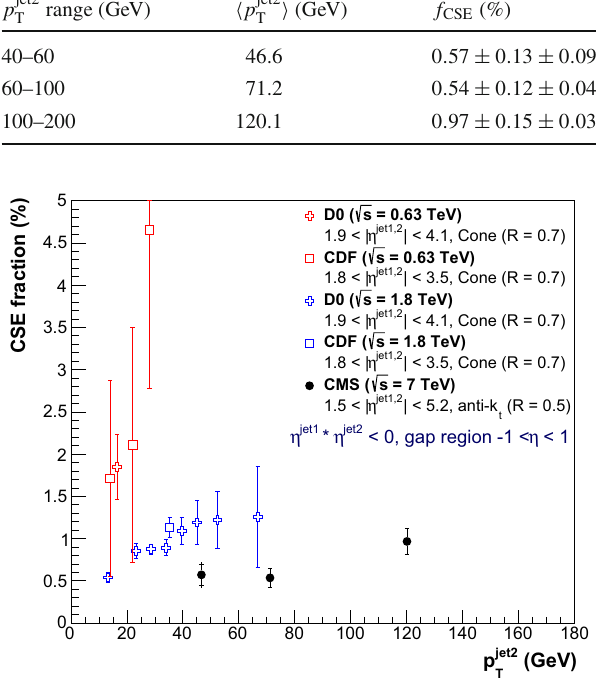
Fig. 8 Fractionofdijeteventswithacentralgap( f CSE )asafunctionof √ p jet2 s = 7TeV, compared to the D0 [27] and CDF [29,30] results at √ T s = 0 . 63 and 1.8TeV. The details of the jet selections are given in at the legend. The results are plotted at the mean value of p jet2 The inner and outer error bars represent the statistical, and the statistical and systematic uncertainties added in quadrature, respectively